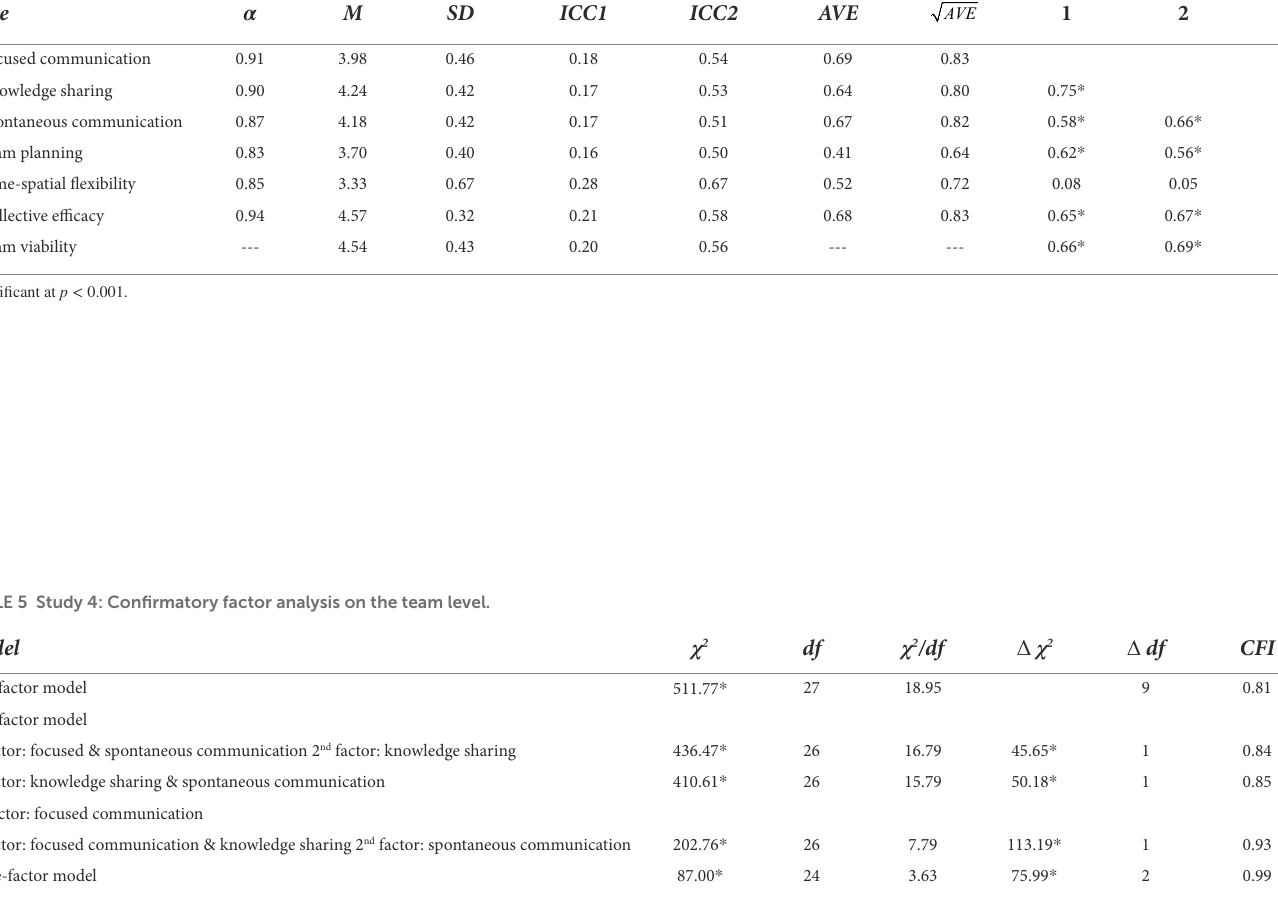
TABLE 4 Study 4: Descriptive statistics, Cronbach’s alphas, correlations, ICCs and AVE.